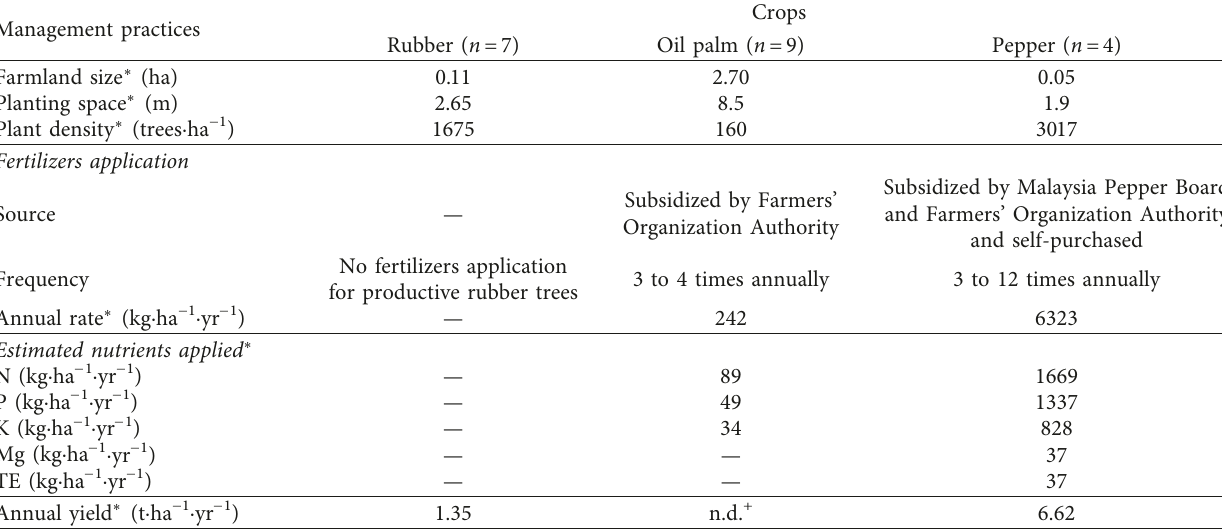
Table 2: Present management practices of smallholder agricultural land uses at the Sabal